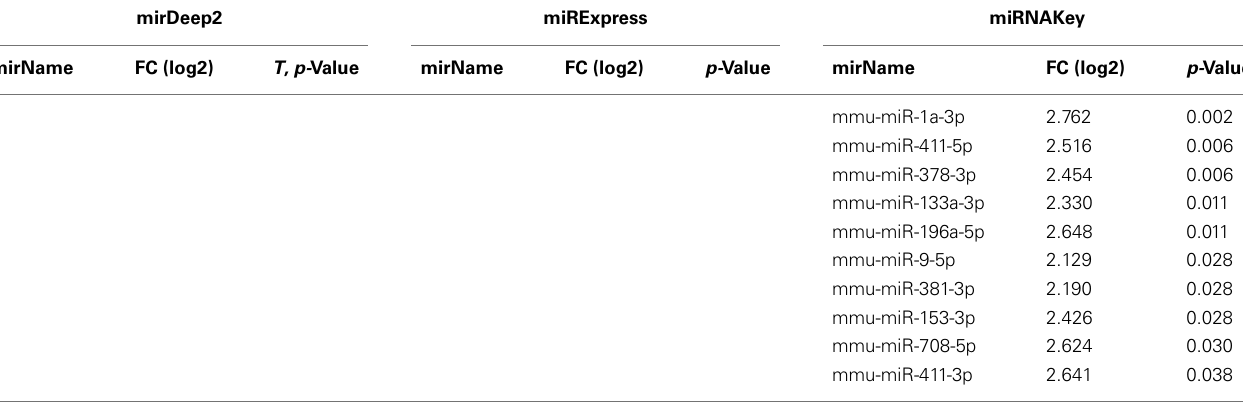
Table 4 | Differentially expressed genes in plasma detected using EdgeR for Sham-Surgery vs. nerve crush.